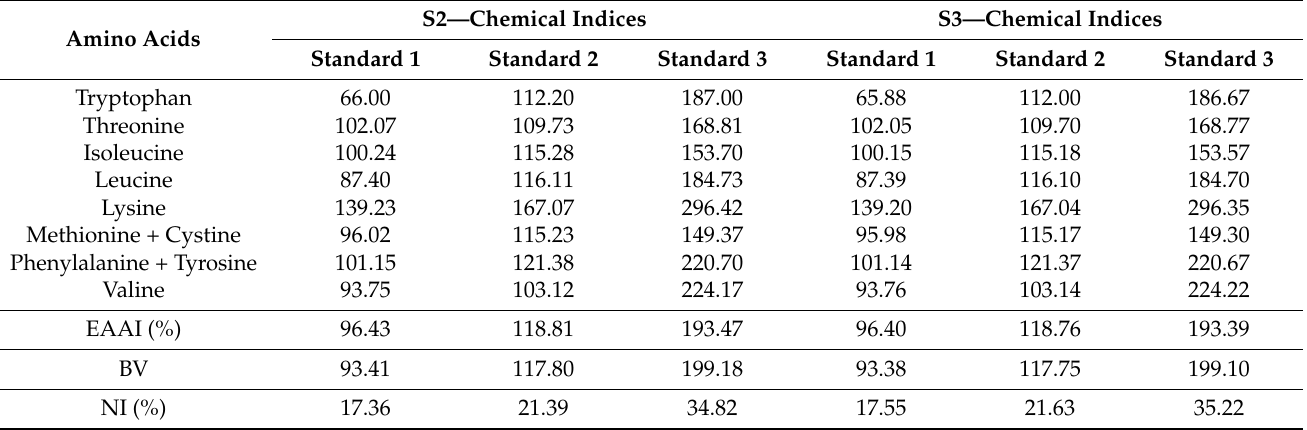
Table 10. Nutritional assessment of the proteins in the Polyodon spathula sturgeons meat, aged two and three